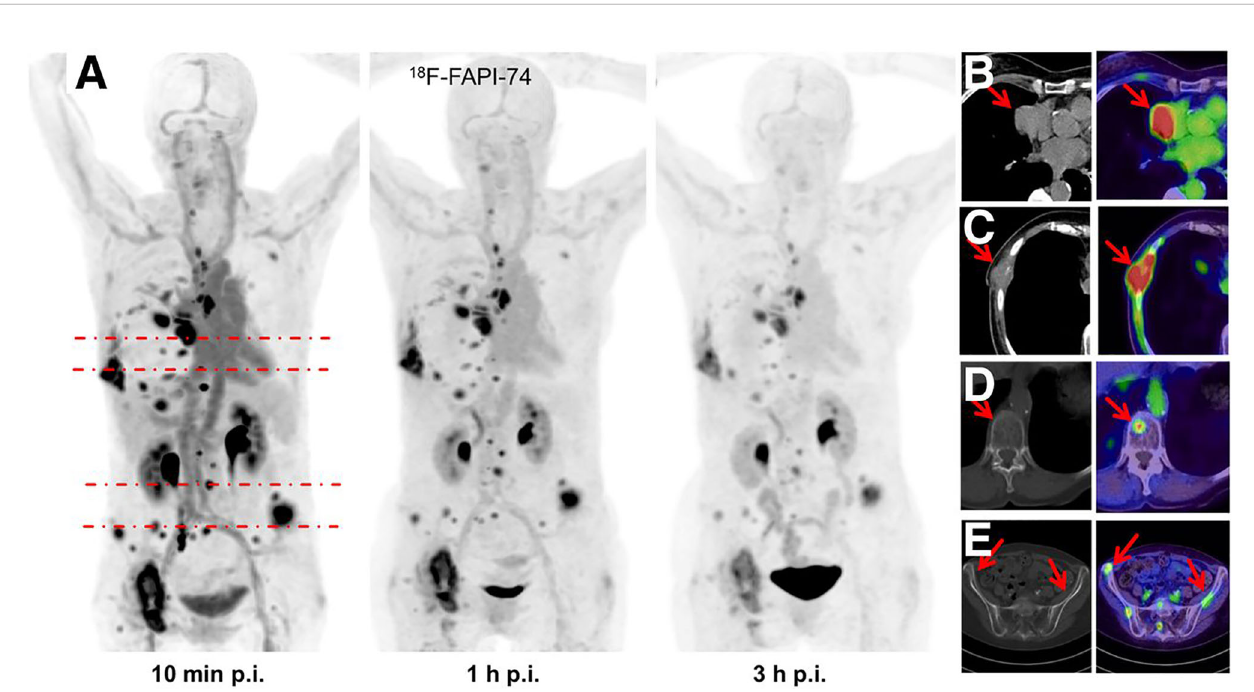
FIGURE 2 | One patient with non – small cell lung cancer who developed systemic metastasis. (A) Maximum intensity projections at 10 min, 1 h, and 3 h after injection of 18 F-FAPI-74 PET. (B) The uptake of 18 F-FAPI-74 was signi fi cantly different between tumor and normal myocardium. (C) FAPI-positive lesions were con fi rmed on CT examination. (D, E) Some bone metastases were detected only by FAPI PET. All highlighted arrows represent FAPI uptake in relation to morphology